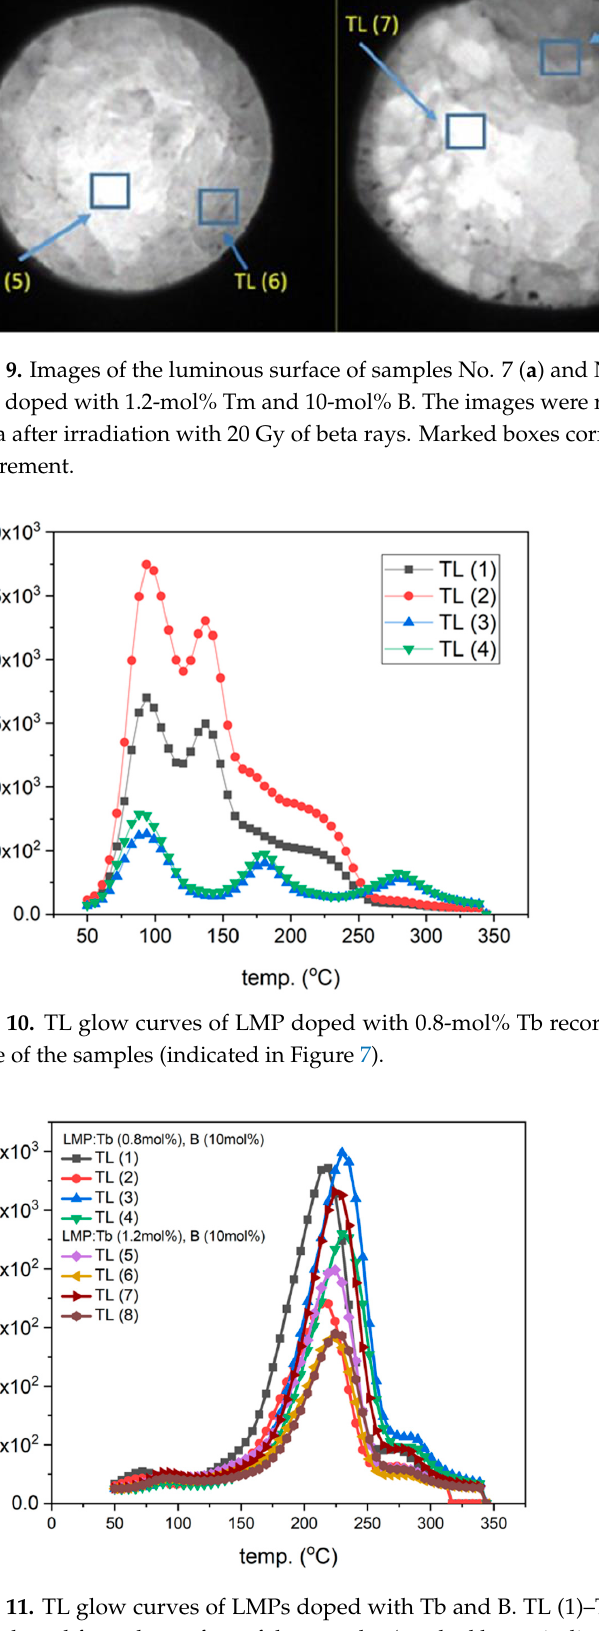
Figure 11. TL glow curves of LMPs doped with Tb and B. TL (1)–TL (8) curves were recorded for areas selected from the surface of the samples (marked boxes indicated in Figures 8 and 9). In contrast, the samples doped with Tm and B, independent of the Tm concentration, presented one evident peak around the temperature of 225 °C, the amplitude and peak position of which changed depending on the sample and location on the sample (Figures 8 and 9). The shape of this TL glow curve was similar to that obtained in a conventional TL reader (Figure 3A). 3.4. Light Microscopy Evident differences in the TL signals of individual surface areas led us to examine the microstructure of the samples. The samples were embedded in resin, polished, and subjected to light microscopic examination, using a range of magnification from 50 to 1000 times. The analysis of microstructures revealed more solidified ceramics than that ob- served for single crystals. Instead of the expected single-crystal structure, we observed a more complex multiphase substructure in all the samples, irrespective of whether they were doped with Tb or Tm (Figures 12–14). Between “smooth” areas, which may indicate the presence of one phase of LiMgPO 4 , there are “hieroglyphic” areas that resemble eu- tectic alloys [37]. It is possible that when the crystal pulling process is too fast, thermal conditions result in crystal solidification, which produces multiphase eutectic-like inclu- sions. A comparison of the microstructure between samples with higher and lower sensi- tivity to ionizing radiation for a given type of crystal did not reveal any significant differ- ences. Such differences might result from the local distribution of multiphase inclusions that affect sensitivity. The multiplicity of phases in these areas indicates a highly complex system of phase coexistence; therefore, a study of the elemental composition of individual areas was necessary.